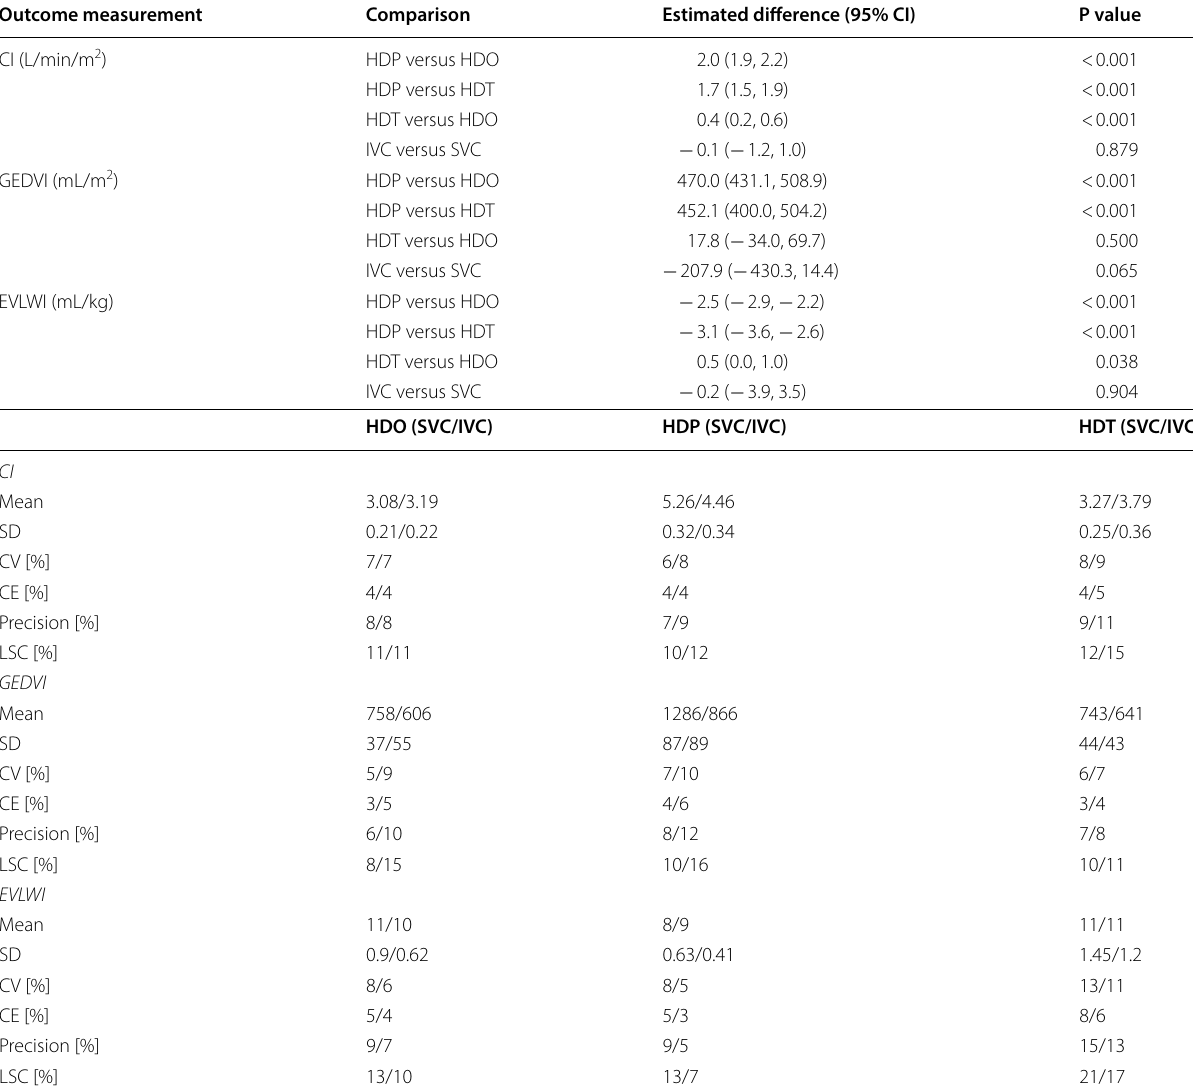
Table 3 Estimated differences and 95% confidence intervals for CI, GEDVI and EVLWI in each setting between time points and between catheter